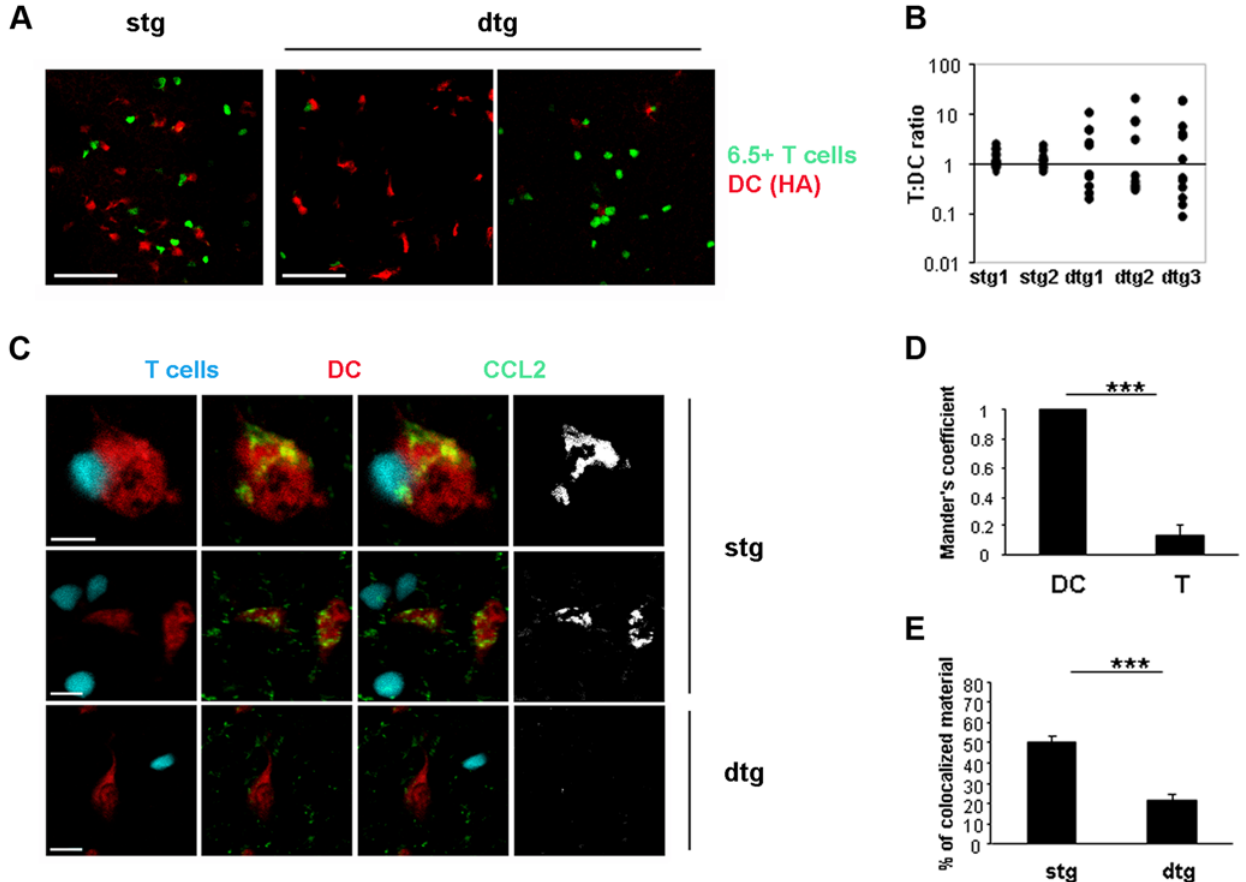
Figure 4. Effects of Tregs on antigen-specific DC-T cell attraction. CFSE-labelled 6.5 + T cells obtained from stg or dtg mice were adoptively transferred into BALB/c recipients. One day later, CMTMR-labelled, HA-loaded DCs were injected into the footpad. 24 h after DC transfer, mice were sacrificed and dLNs were frozen and cut for histological examination. (A) Representative images of two independent experiments are shown. Bar, 70 m m. (B) Quantitative analysis of the experiment in (A) on two LN sections from mice that had received T cells from stg donors (stg 1 and stg 2) and three LN sections from mice that had received T cells from dtg donors (dtg 1, dtg 2, dtg 3). Each dot represents the T cell/DC ratio (calculated as described in the Methods) for a single 250 6 250 m m quadrant. A non parametric ANOVA test was used and the difference between the higher 50% and the lower 50% values within each condition showed that there was no significant difference for the stg mice and a significant difference for the dtg mice (p , 0.001). (C) Tissue sections were stained for CCL2. Bar, 10 m m. (D) Mander’s co-localization coefficient was determined as described in the Methods and was used to understand if CCL2 had been produced by DCs or T cells, in mice that had received T cells from stg donors. (E) The ‘‘percentage of material co-localized’’ was determined as described in the Methods and represents the percentage of DC material (voxel signal intensity) that co-localizes with CCL2 in LN sections of mice that received T cells from stg or dtg donors.